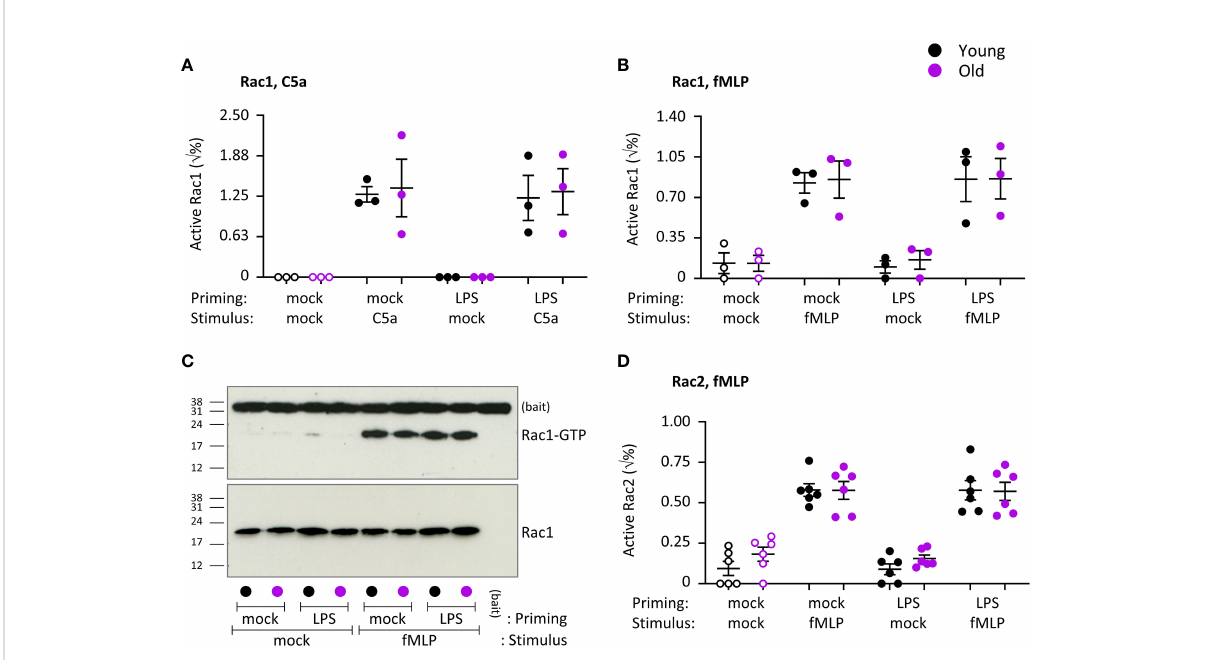
FIGURE 10 Hornigold K et al. Chemoattractant-stimulated Rac activity is normal in neutrophils from old mice. Neutrophils from young (8-10 weeks, black symbols) and old (24 months, purple symbols) mice were primed with 1 m g/ml LPS or mock-primed for 90 min, prior to stimulation for 10 s with 25 nM C5a (A) or 3 µM fMLP (B-D) , or mock-stimulation as indicated. Rac activity was assessed by Pak-CRIB pull down. GTP-Rac (active) and total Rac levels were analyzed by western blotting with Rac1 and Rac2 antibodies and quanti fi ed by densitometry using ImageJ. (C) Representative western blots from one experiment as in (B) . Data in (A) and (B) are mean ± SEM of 3 independent experiments and data in (D) of 6; each dot represents the mean of one experiment. Statistics were two-way ANOVA with Sidak ’ s multiple comparisons test and showed no differences between